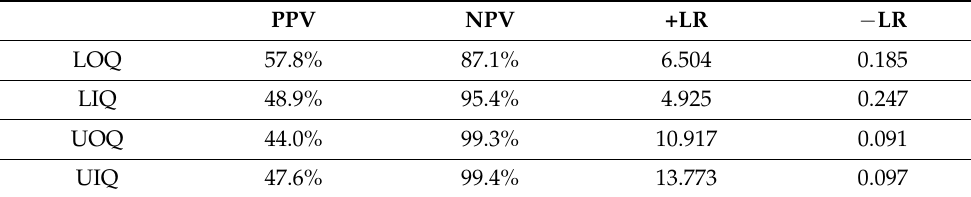
Table 10. Ultrasound Positive and Negative Predictive Values and Likelihood